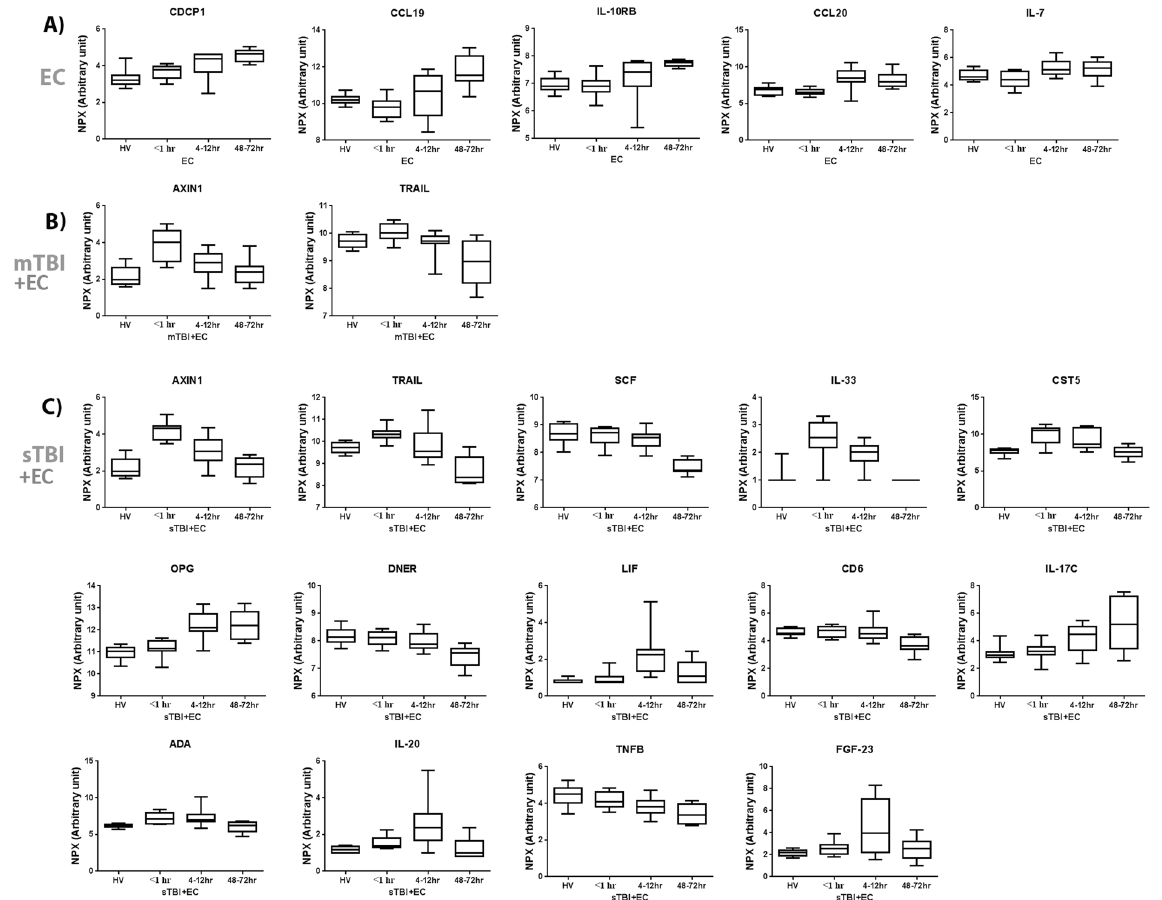
Figure 1. Comparison of temporal protein expression within each of the injury groups. Within injury groups of EC patients, mTBI + EC patients and sTBI + EC patients, expression of inflammatory proteins significantly differed between HV, < 1 hr, 4–12 hr and 48–72 hr time